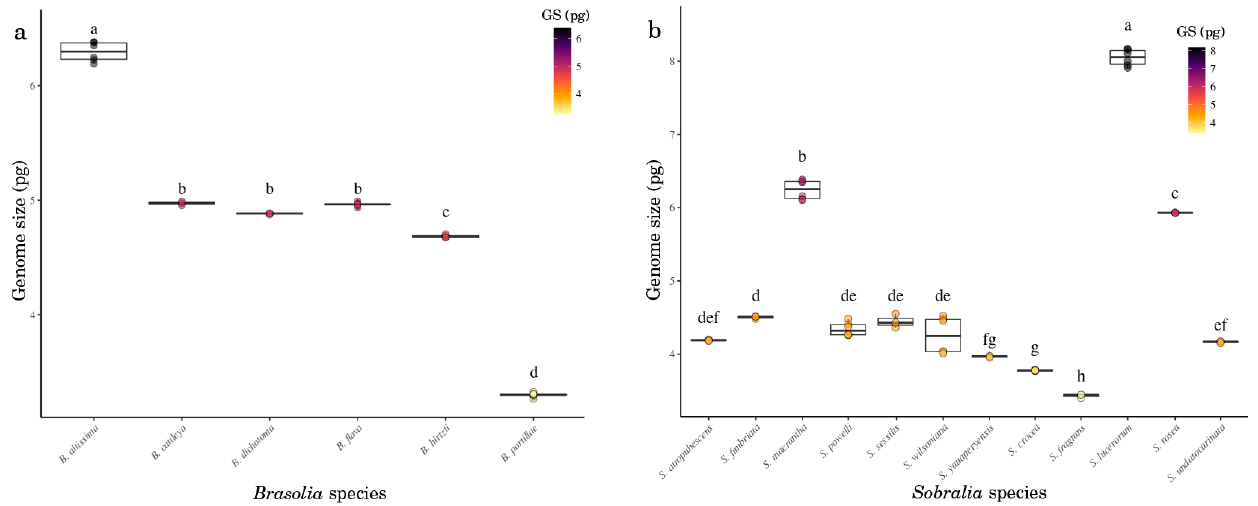
Figure 5. Brasolia ( a ) and Sobralia ( b ) genome sizes (1C-value). The 1C-value indicated by the same letter are not significantly different at p ≤ 0.05 according to the Duncan’s multiple range test. 2.3. Ancestral Reconstruction of Chromosome Number and Genome Size Indicate x = 25 and Small Genome Size for the Common Ancestor of Brasolia-Elleanthus-Sobralia Regarding the ancestral reconstruction for chromosome number, for both trees, the ChromEvol suggested the same model as the best one: constant rate without duplication (Table 2). However, considering the Δ AIC < 2, no differences were found among constant rate, constant rate with demi-polyploidy and the best model for ML and BI phylogenies (Table 2). The Model Adequacy test confirmed the null model, constant rate without polyploidy, as the most adequate considering the variance and entropy tests ( p = 0.13 and 0.21 for ML and p = 0.31 and 0.35 for IB, respectively) but not the parsimony ( p = 0.00 for both ML and BI), suggesting that the chromosome number transitions are variable among clades. The best models highlight the importance of dysploidy variation as the main mech- anism in chromosome evolution in Brasolia, Elleanthus and Sobralia .